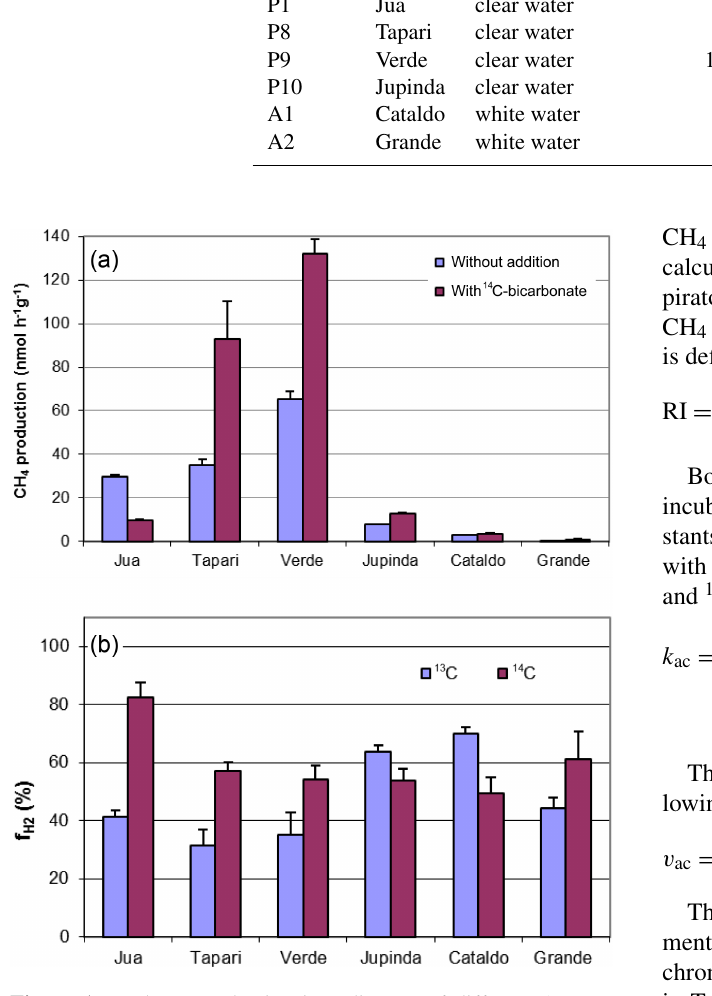
Figure 1. Methane production in sediments of different Amazo- nian lakes: (a) rates of CH 4 production and (b) fractions of hy- drogenotrophic methanogenesis, both determined in the absence and the presence of radioactive bicarbonate. The data in the ab- sence of radioactive bicarbonate are the same as published in Ji et al. (2016), when f H was determined from values of δ 13 C 2 (mean ±